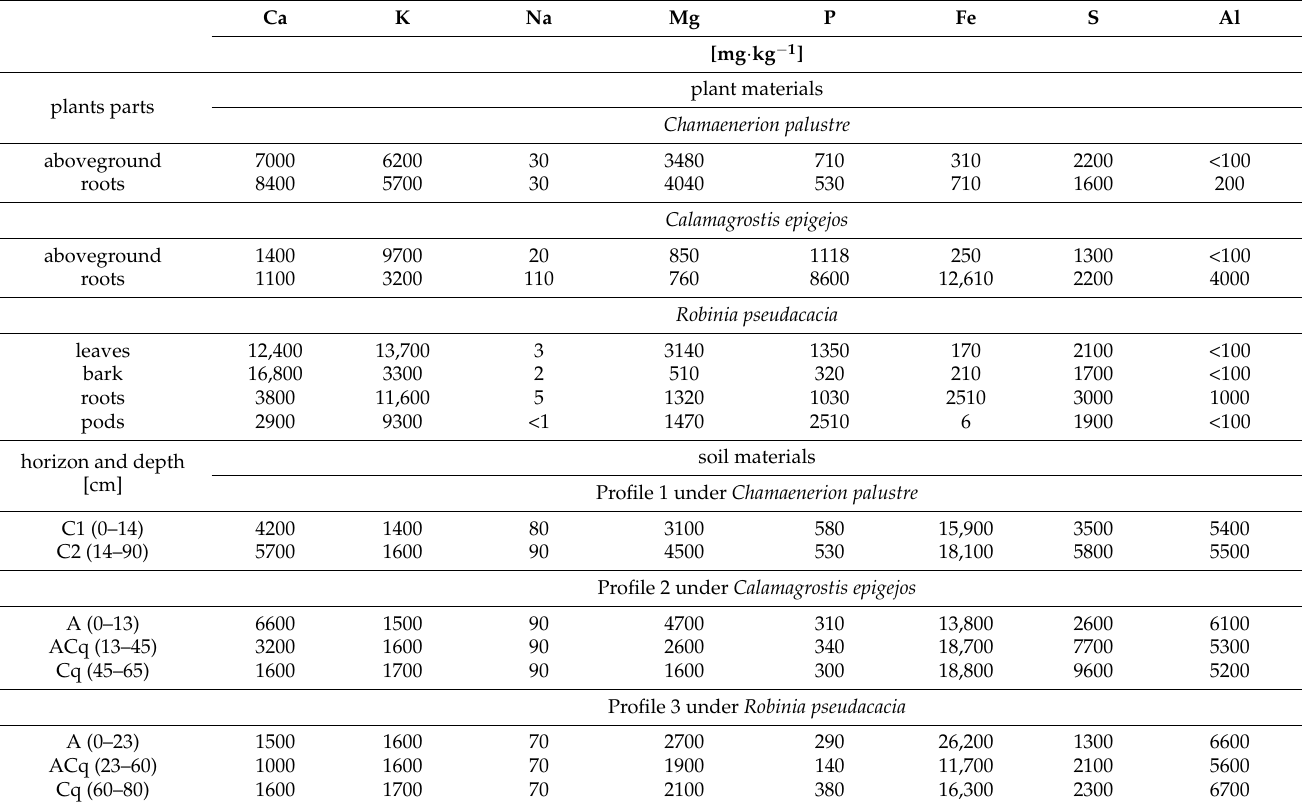
Table 3. Content of major elements in the plant materials and